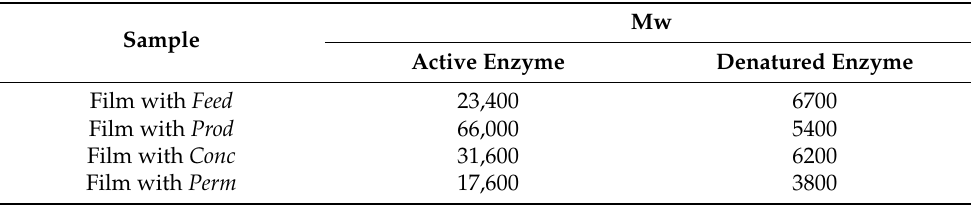
Table 3. The average molecular weight of the lignin derivatives in cast films with and without enzymatic